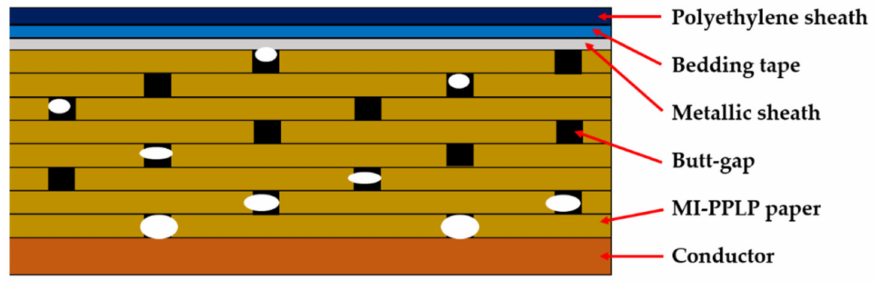
Figure 1. Void defects created in the butt-gaps on the conductor side of the mass impregnated polypropylene laminated paper (MI-PPLP) cable by